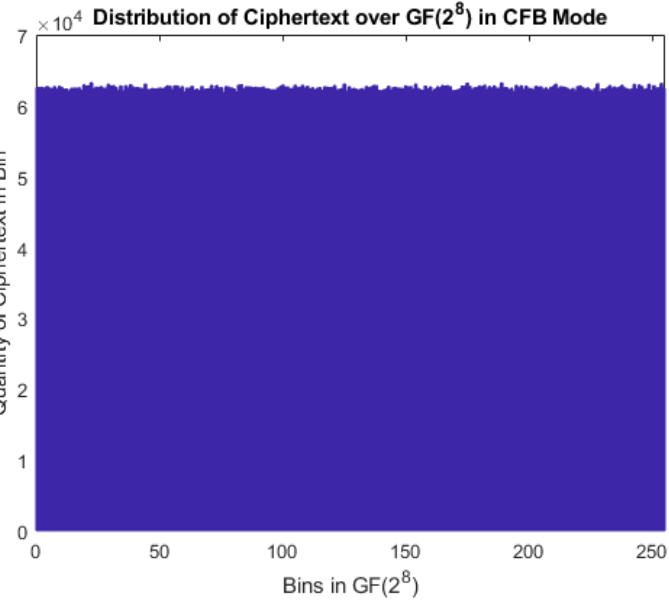
Figure 6. Distribution of ciphertext across GF(2 8 ) (CFB Mode).